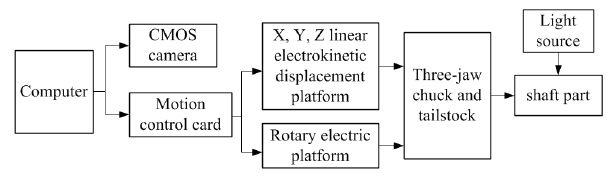
Figure 1. Schematic diagram of an image acquisition system.